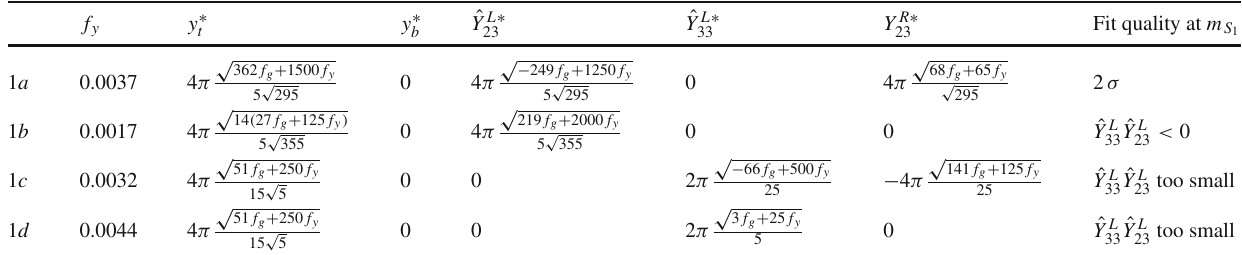
Table 2 Possible fixed points and the corresponding f y of the SM+ S 1 system with the left- and right-handed couplings. The low-energy prediction for the NP sector is shown in the last column on the right